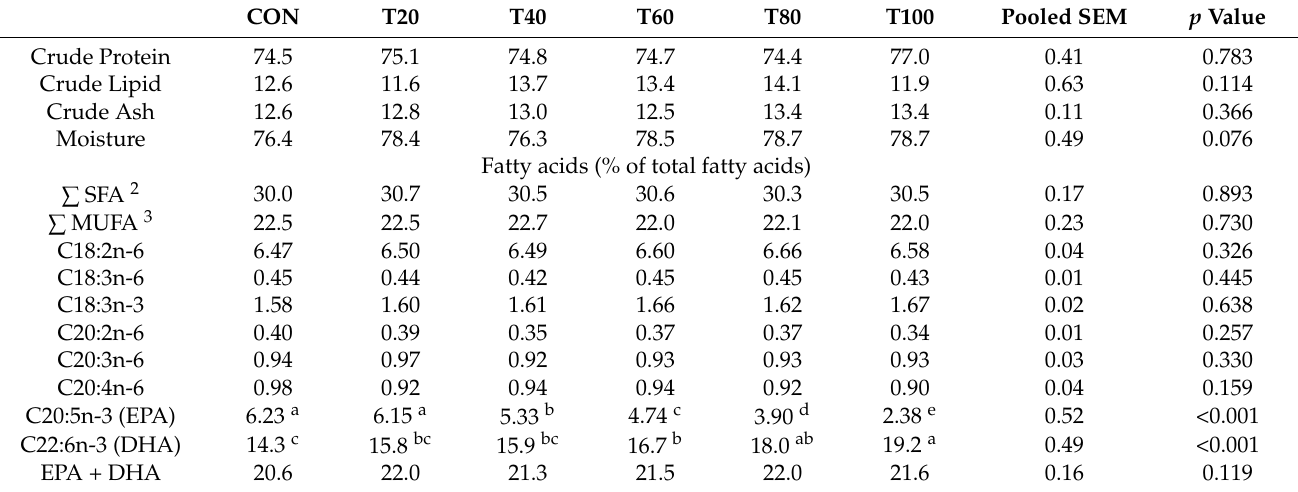
Table 5. Whole body proximate and fatty acids composition (%) of juvenile rainbow trout fed experimental diets for 8 weeks 1 .